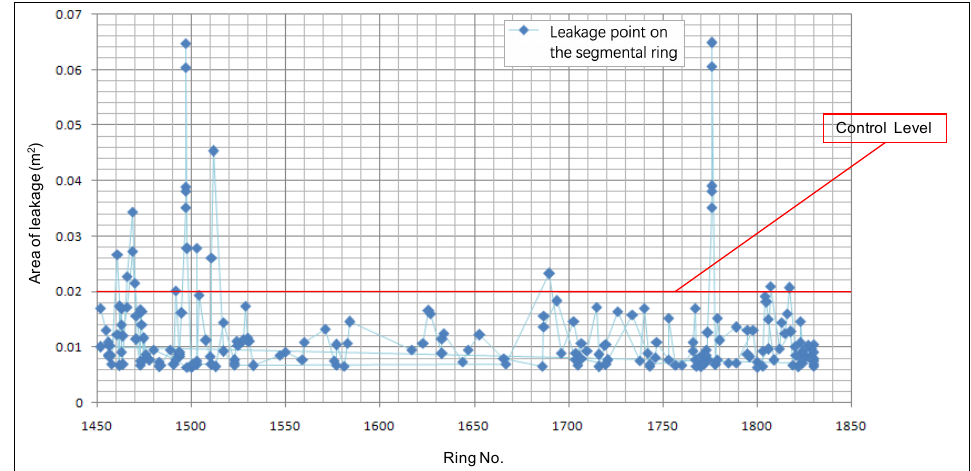
Figure 13. Areas of identified leakages in the metro